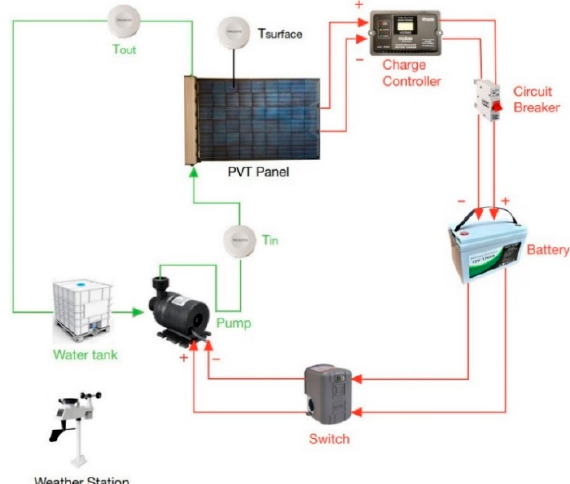
Figure 1. PVT system layout.